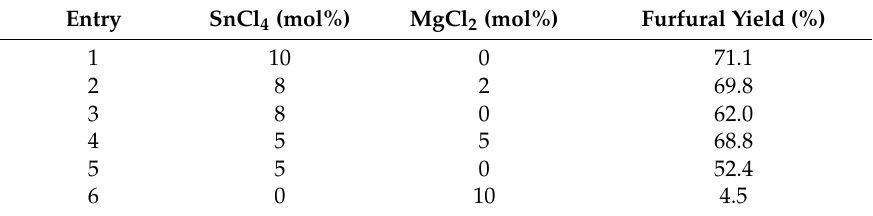
Table 1. Effect of different dosage of SnCl 4 and MgCl 2 on the dehydration of xylose into furfural. Entry SnCl 4 (mol%) MgCl 2 (mol%) Furfural Yield (%) 1 10 0 71.1